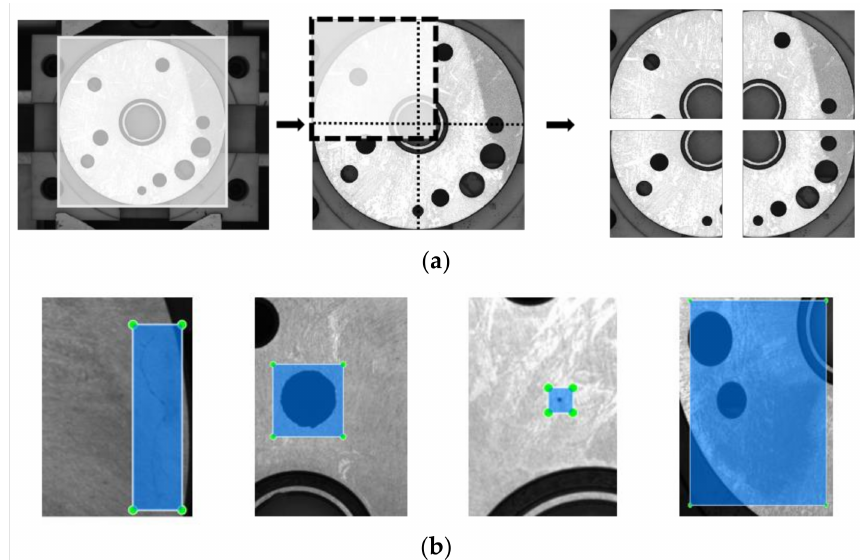
Figure 6. Data processing and labelling. ( a ) Image preprocessing, ( b ) four different classes of surface defects: scratched, bruises, sand hole,